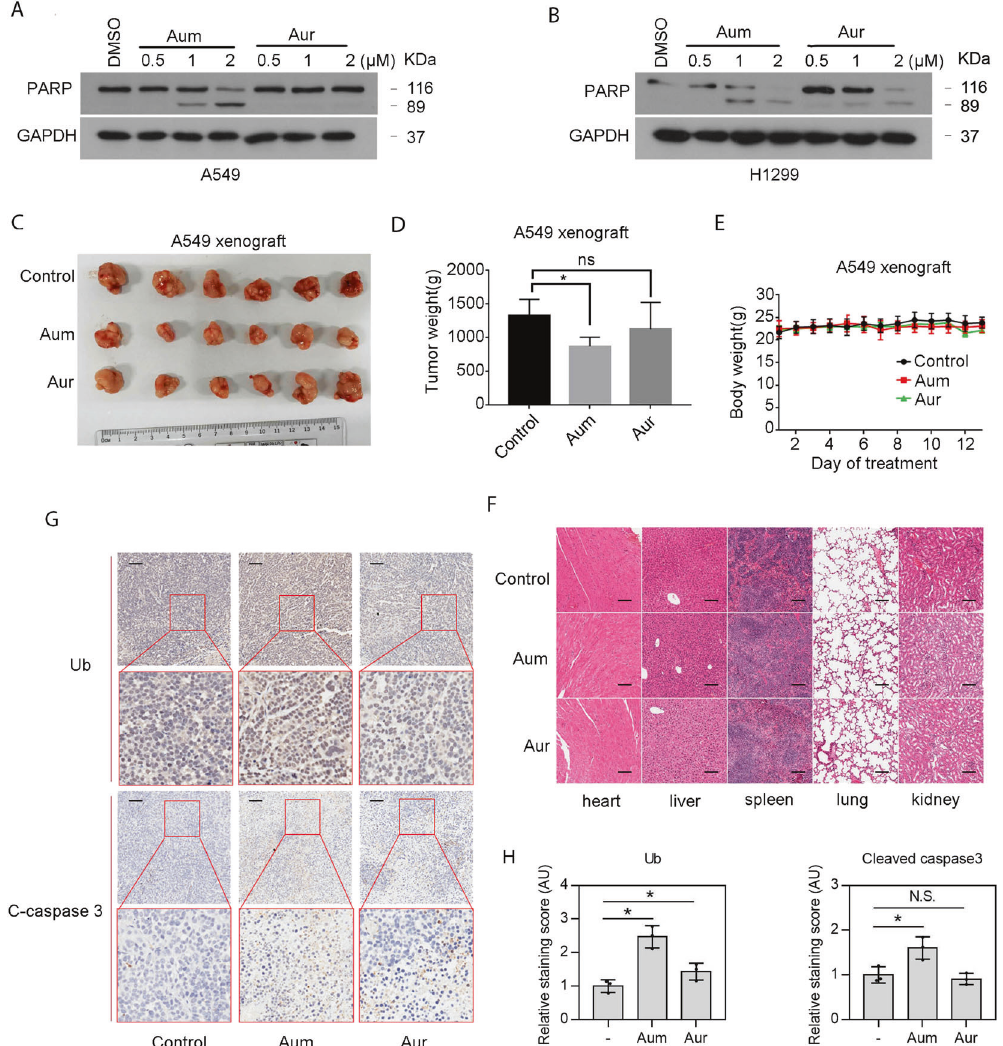
were analyzed with western blotting. GAPDH were used as a loading control. Nude mice bearing A549 xenograft tumors were intraperitoneally treated with vehicle (DMSO:Kolliphor:normal saline = 1:3:6), or aumdubin (Aum) or aurano fi n (Aur) (8.8 μ mol/kg) everyday for 13 days after inoculation of A549 cells. Tumor image ( C ), tumor weight ( D ), body weight ( E ), and histopathology ( F ) were shown. Mean ± s.d. ( n = 6). * P < 0.05. Representative micrographs ( G ) and relative quanti fi cation ( H ) of immunohistochemical staining of tumor tissue for ubiquitinated proteins (Ub) and cleaved caspase 3 in nude tumor tissues was shown. Scale bars, 50 µm. Mean ± s.d. ( n = 3). * P <